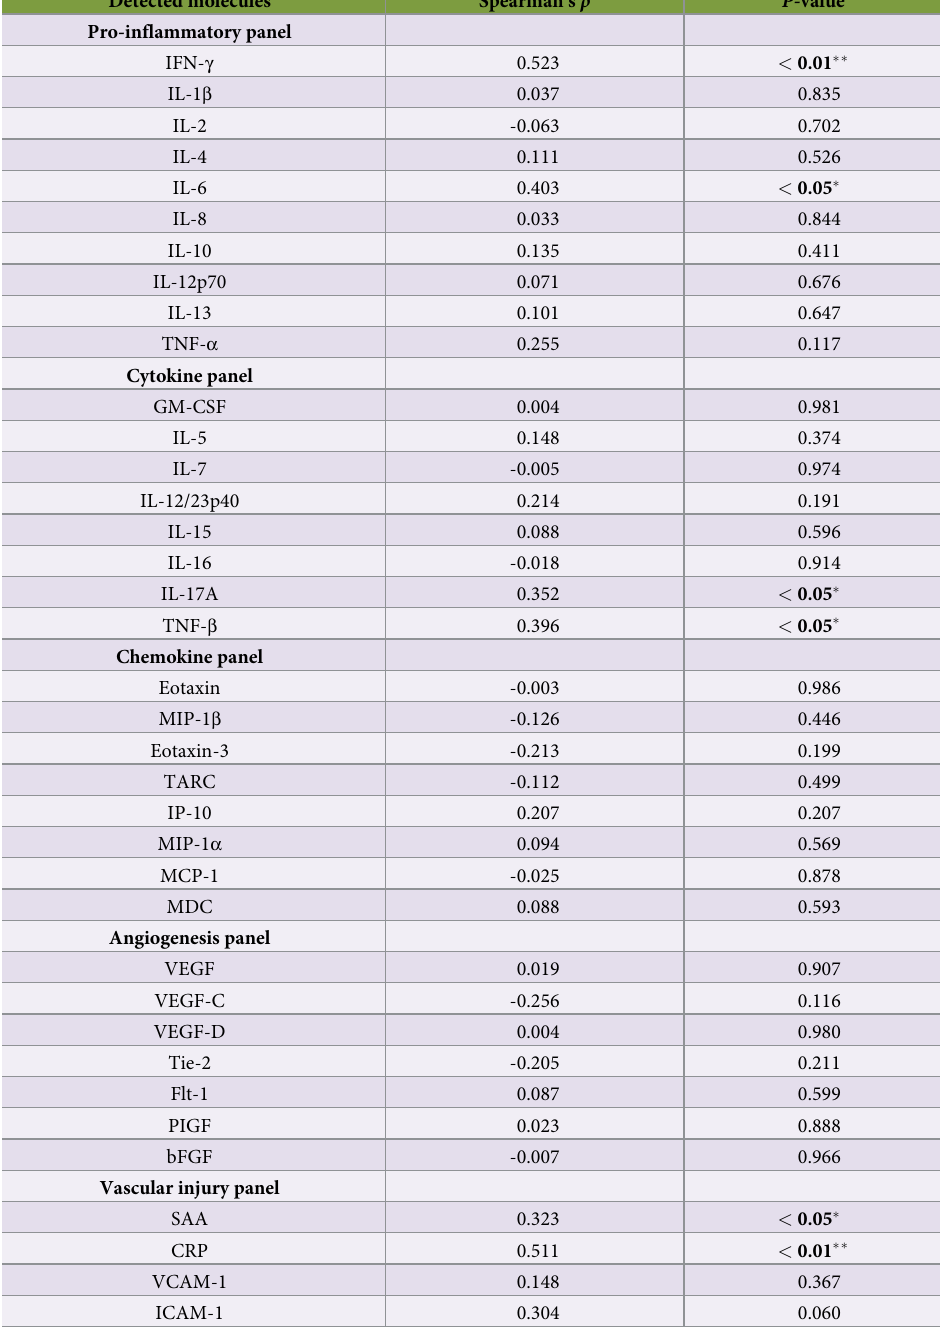
Table 3. Correlations of fecal calprotectin levels (mg/kg) with serum levels of all detected molecules (pg/mL) in patients with Crohn’s